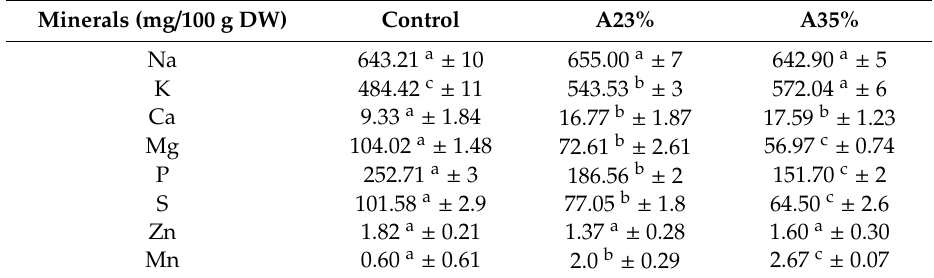
Table 4. Mineral composition of the GFB with the incorporation of di ff erent ratios of acorn flour (A23% and A35%) and comparison with the control samples. DW: dry